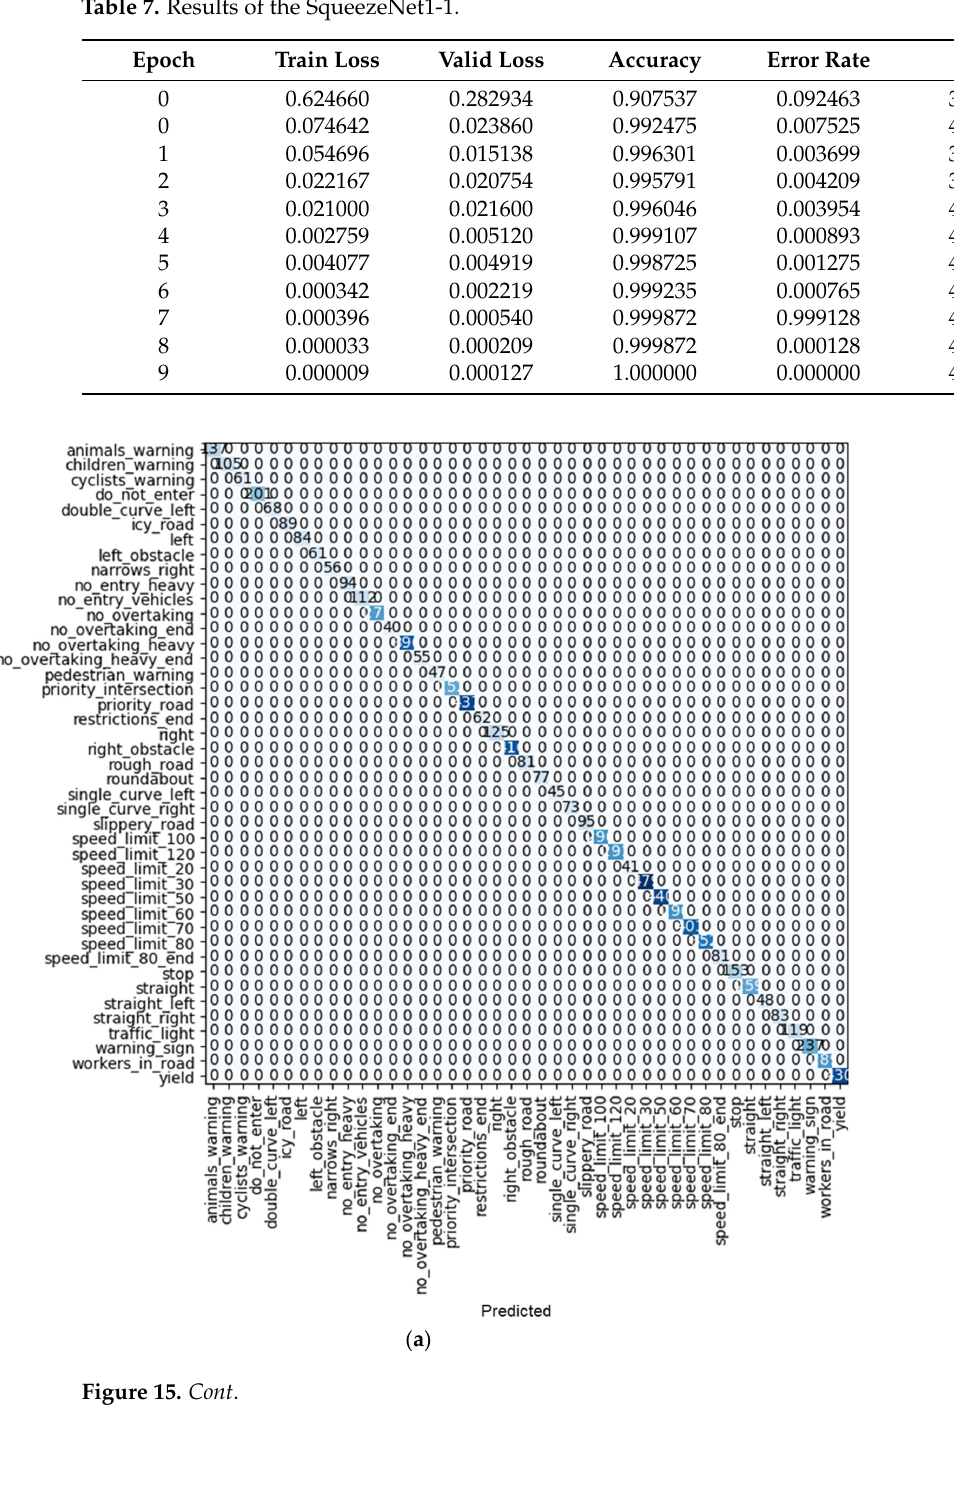
( b ) Figure 15. ( a ) Confusion matrix and ( b ) loss rate during training with VGG16_bn.